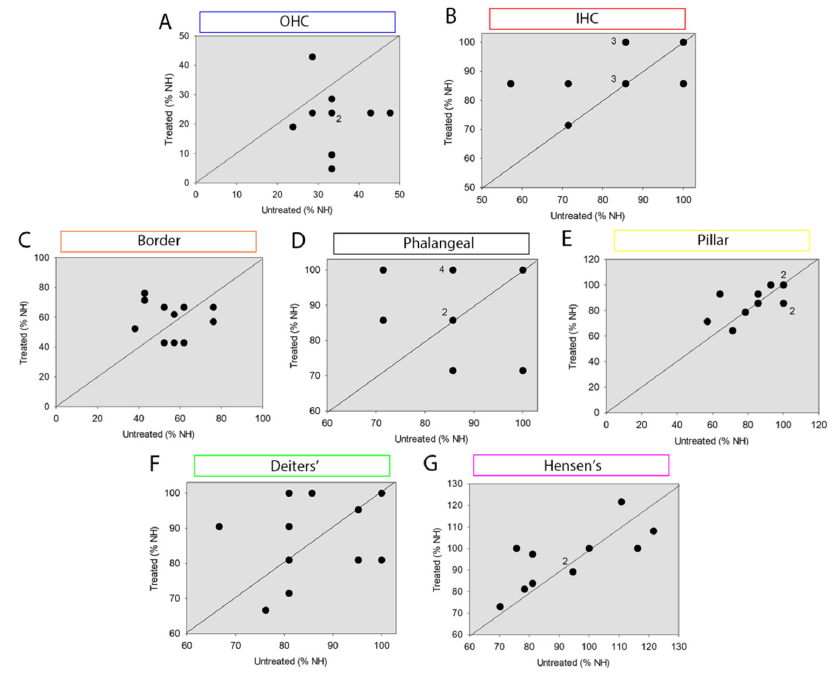
Figure 6. Scatter plot of the number of sensory and non-sensory cells of BDNF-GS and untreated (6WD) cochleas in individual animals. Cell count of ( A ) outer hair cells (OHC), ( B ) inner hair cells (IHC), ( C ) border, ( D ) phalangeal, ( E ) pillar, ( F ) Deiters’, ( G ) Hensen’s cells. The scatter plots show the total number of SCs of treated versus untreated cochleas of individual animals. Number of cells is expressed as percentage of NH (100%). Incidentally overlapping data points are indicated by the adjacent number, indicating the number of overlapping data points. Diagonal lines represent y = x.